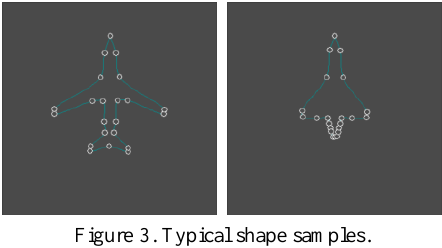
Figure 3. Typical shape